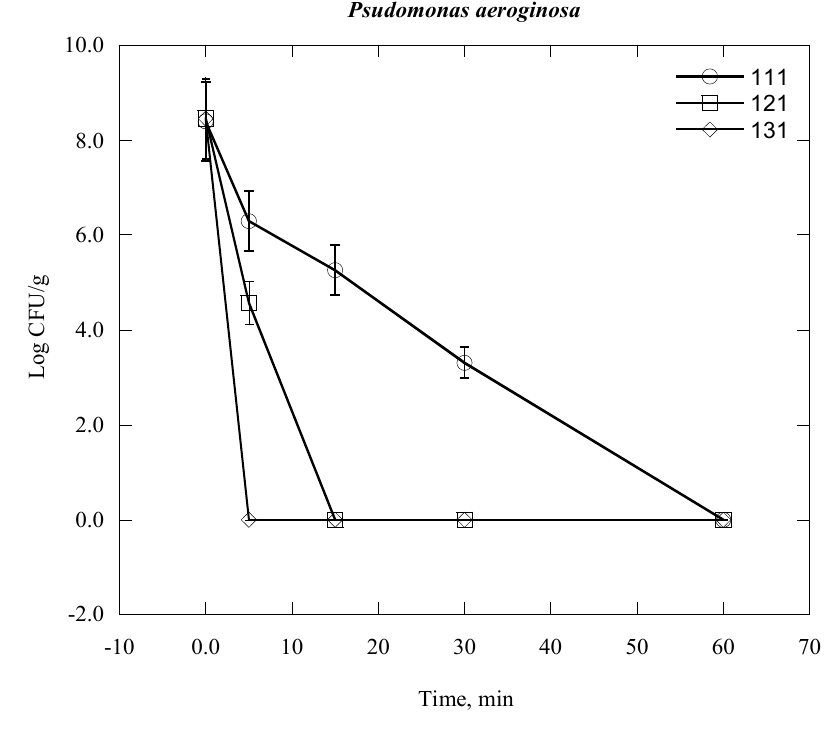
Figure 2. Inactivation of P. aeruginosa in clinical solid waste using steam sterilization. Experimental conditions: (○), 111 °C (8 psi); (□), 121 °C (15 psi) and (◊), 131 °C (27